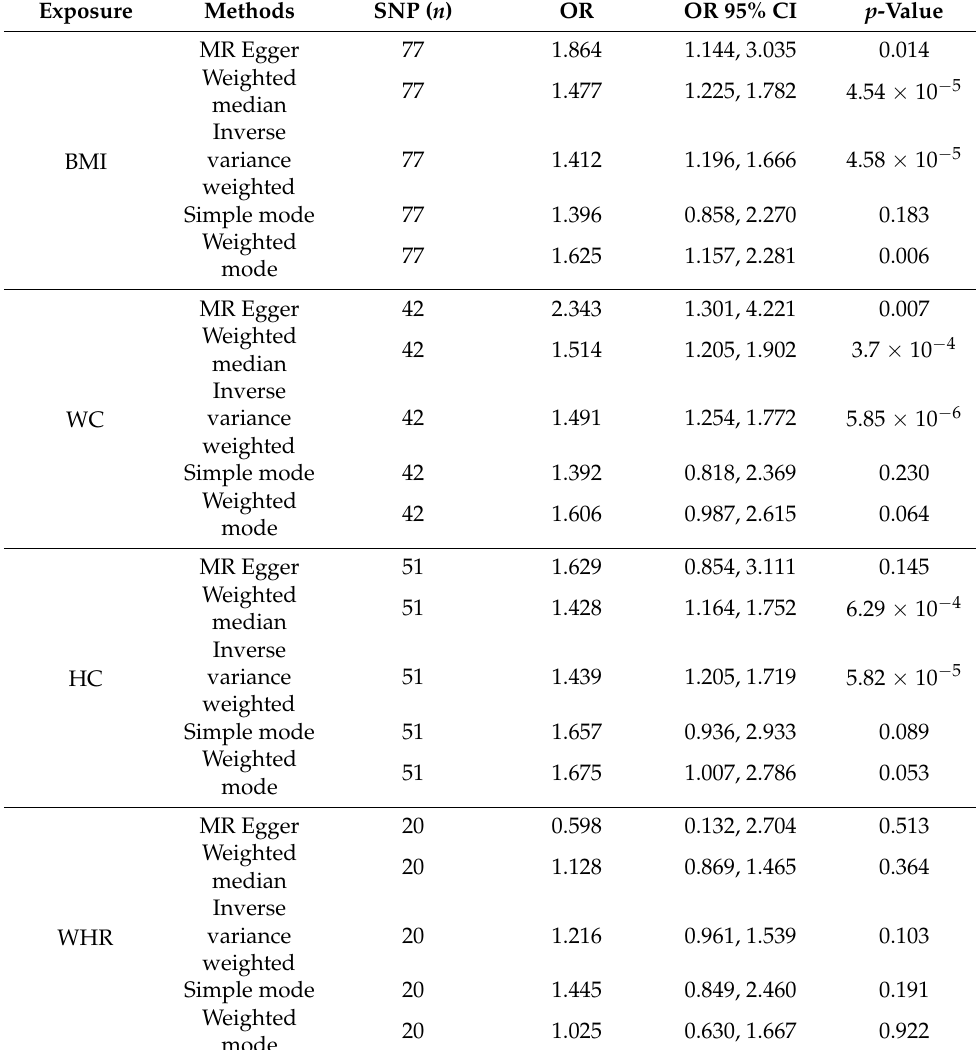
Table 2. The Mendelian randomization analysis results with regard to causal effect of BMI, WC, HC, and WHR on Hip